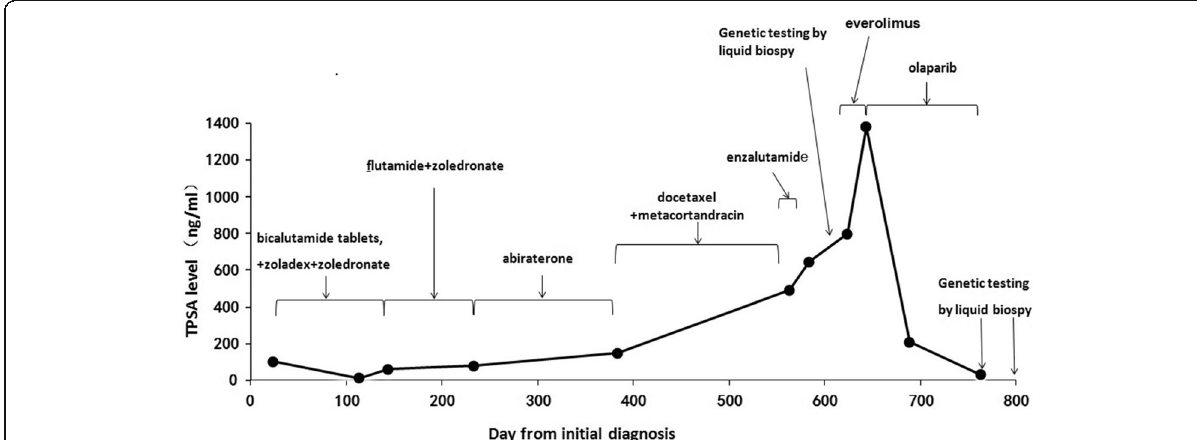
Fig. 1 Clinical course of the patient. Serum TPSA level was measured for disease monitoring. The timeline and duration of different treatments were indicated, as well as the time points for genetic